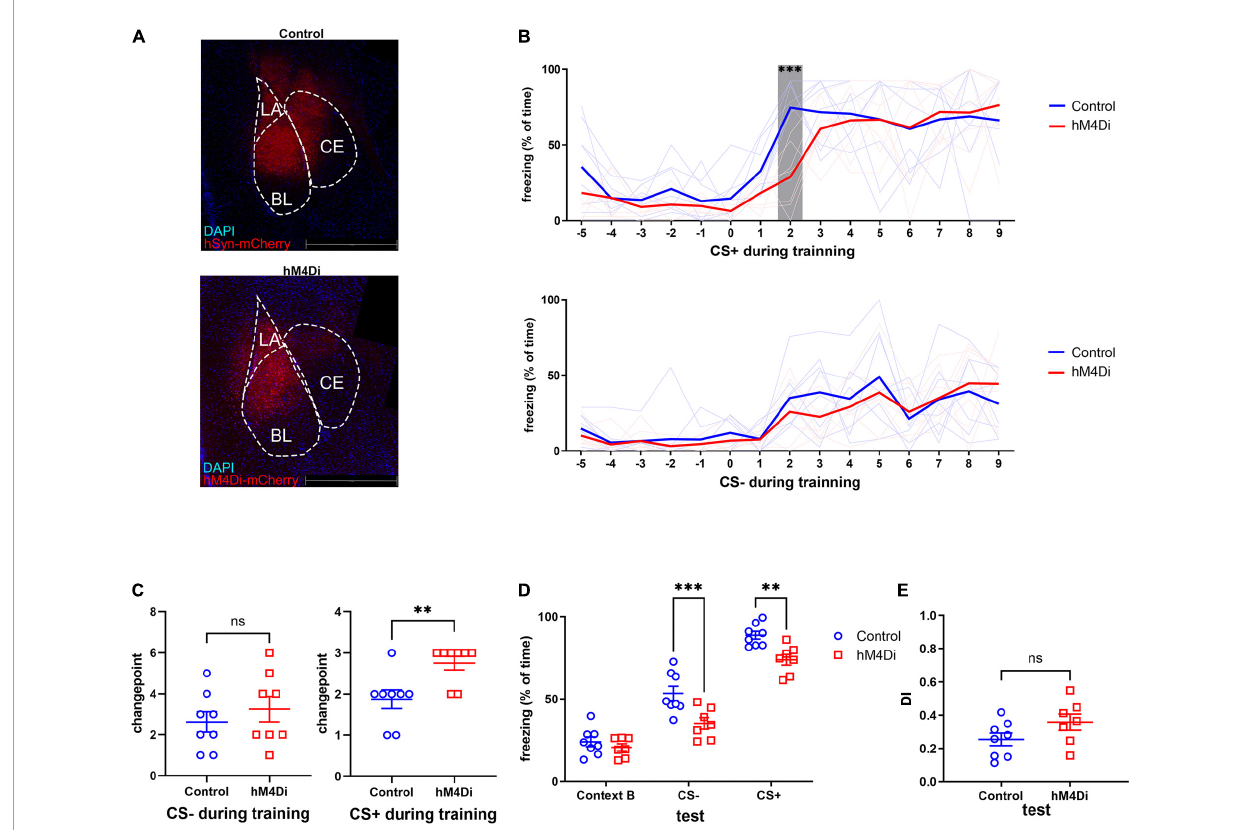
FIGURE3 Chemo-genetic inhibition of amygdala impaired fear memory rather than fear generalization. (A) Images of hM4Di and control virus expression in the amygdala (red: mCherry, blue: DAPI). (B) Freezing to CS+ decreased under amygdala inhibition (two-way ANOVA, F 1 , 14 = 2.25, p = 0.1558, Tukey’s multiple comparisons test, ∗∗∗∗ p 2 [ CS + , CTR vs hM4Di ] < 0.0001). Freezing to CS- was not affected (two-way ANOVA, F 1 , 14 = 0.3796, p = 0.5477). (C) Inhibition of amygdala caused a delay on changepoint of fear response to CS+ during training (CS+ unpaired two-tailed